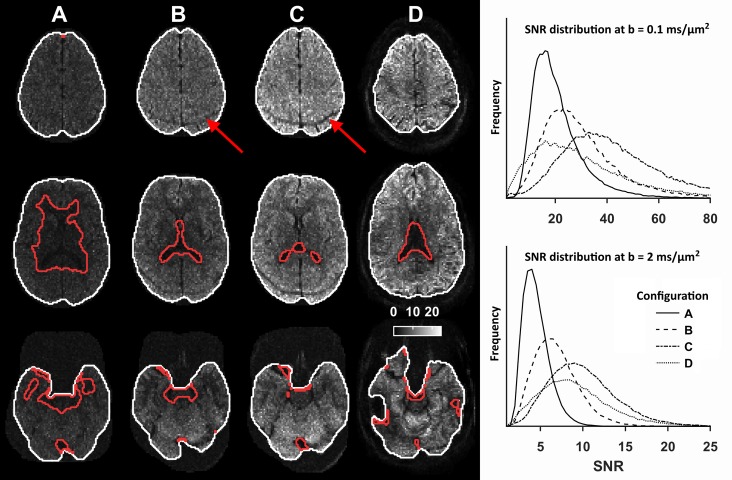
SNR maps at b = 2 ms/μm2
in three transversal slices for configurations A-D and SNR distributions in the brain parenchyma at b = 0.1 and 2 ms/μm2 (histograms). White outlines show the outer perimeter within which SNR > 3, and the red outlines show regions where SNR < 3. At high b-values, images from all systems exhibited low SNR in the ventricles due to the high diffusivity of CSF. Configuration A shows low SNR in the central and inferior parts of the brain. Configuration C exhibited the highest SNR across all b-values, but also a posterior rim of low SNR caused by poor fat suppression (red arrows). Configuration D generally exhibited high SNR in the peripheral regions; in the lower parts of the brain, it exhibited a heterogeneous SNR. It also exhibited an irregular perimeter in the inferior part of the brain, which was likely caused by local field heterogeneity in proximity to the ear canal and poor RF homogeneity, both commonly associated to dMRI at ultra-high field strengths [58].